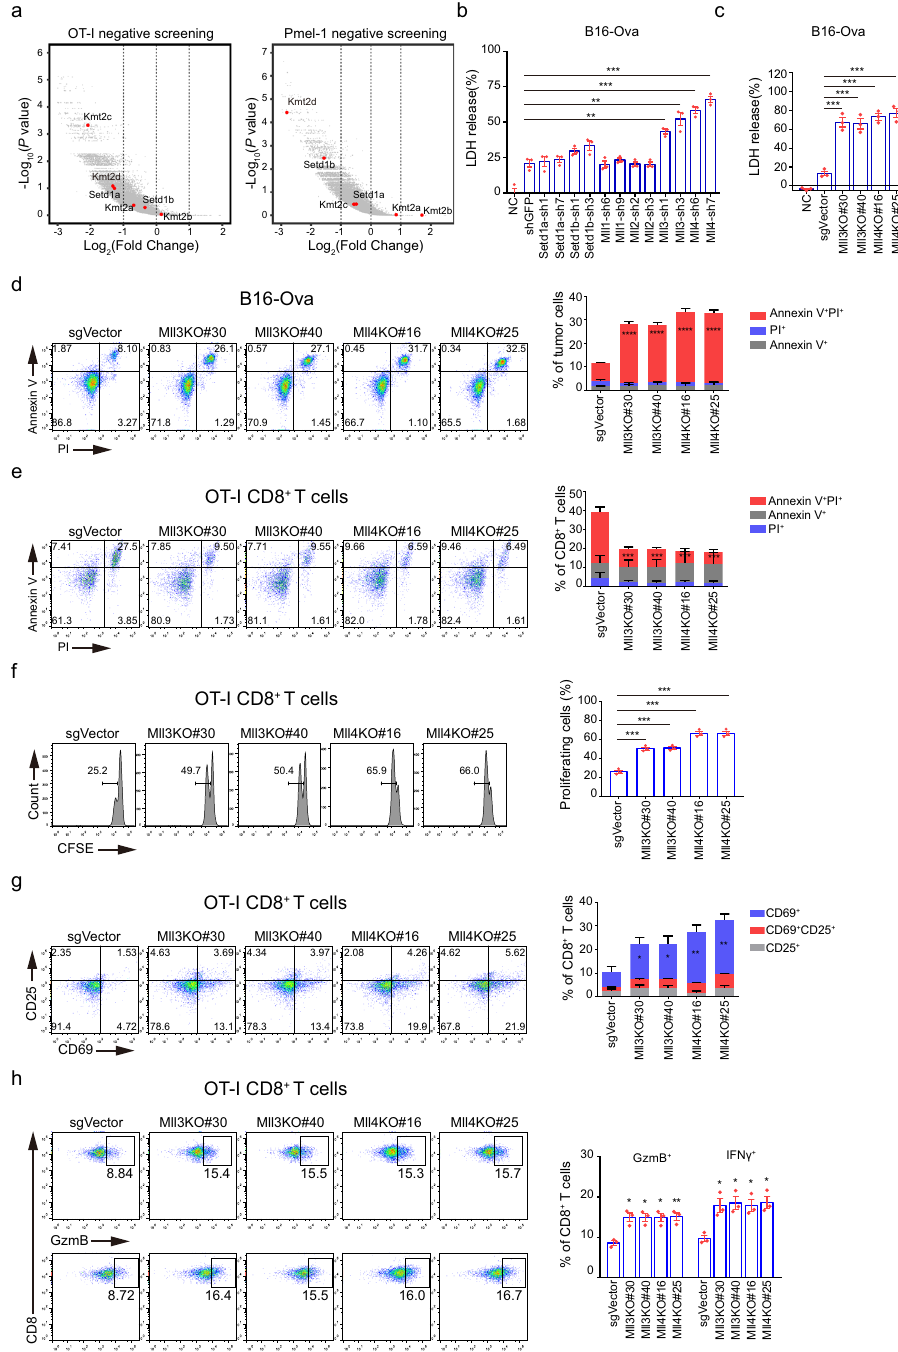
Fig. 1 | Loss of Mll3 and Mll4 in tumor cells stimulates activation and cyto- toxicityofantigen-speci fi cCD8 + Tcellsinvitro.a Volcanoplotsshowinginvitro CRISPR/Cas9screeningoftumor-cell-intrinsicfactorsthatregulatescytotoxicityof OT-I and Pmel-1 CD8 + T cells. Genes were plotted based on mean log2 fold change of gRNA counts compared to control selection. H3K4 methyltransferases of the COMPASS family were highlighted in red. Datasets for OT-I and Pmel-1 screening were from Panet al. 43 and reanalyzedinthis study. b B16-Ova tumor cells depleted for the indicated H3K4 methyltransferase were incubated with OT-I CD8 + T cells at an effector to target (E/T) ratio of 10:1 for 24h. OT-I T-cell-mediated killing was determined by lactate dehydrogenase (LDH) release-based cell death